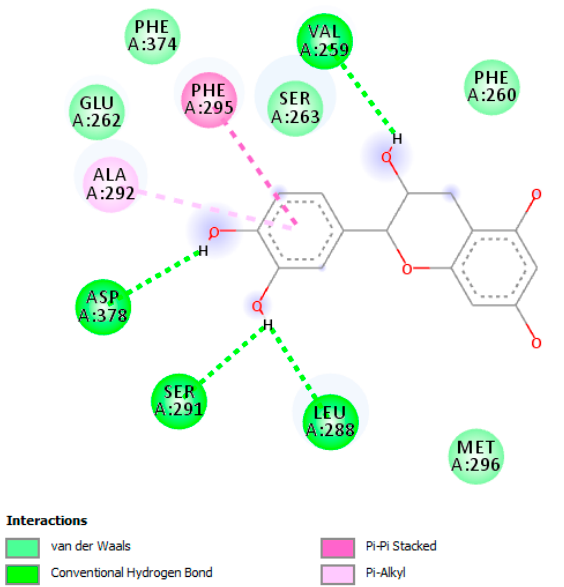
Figure 5. Putative interaction between catechin and the MATE transporter AtDTX14 (PDB:5Y50) as a homology model for describing the structure of the multidrug efflux system transporters of P. aeruginosa (pmpM). Free energy of binding ( Δ G) and affinity (Ki) are − 7.1 kcal/mol and 6.3 µM, respectively.